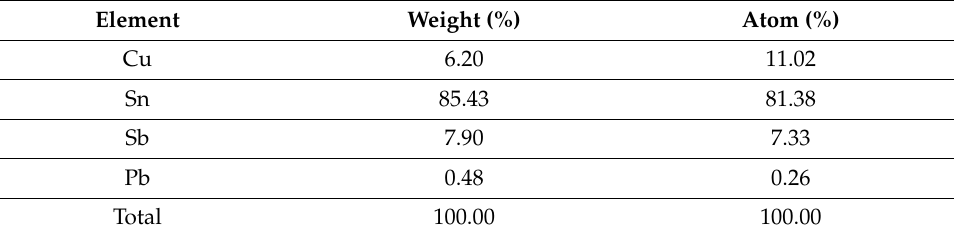
Table 1. Chemical composition of B89 alloy.